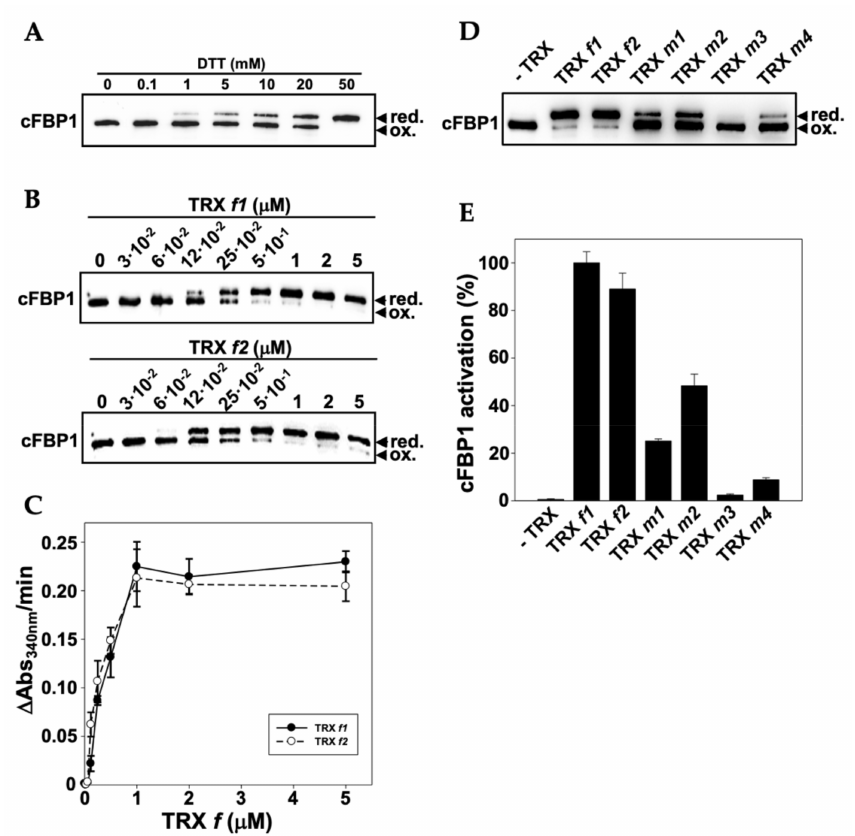
Figure 10. In vitro redox activation assays of cFBP1 by TRXs f and m . ( A ) Reduction assay and Western blotting experiment to determine the DTT concentration necessary to reduce cFBP1. ( B , C ) Western blotting experiments and FBPase activity assays, respectively, to calculate the TRX f concen- trations needed to fully reduce cFBP1. Numbers in ( B ) show the TRX f concentrations ( µ M) used to activate cFBP1. ( D , E ) Western blotting experiments and FBPase activity assays, respectively, to determine TRXs m capacity, relative to TRX f , to reduce and activate cFBP1. Equal quantities of TRXs (1 µ M) were used for cFBP1 activation. red., cFBP1 reduced; ox., cFBP1 oxidised. Three technical replicates were carried out for cFBP1 activity determinations ( C , E